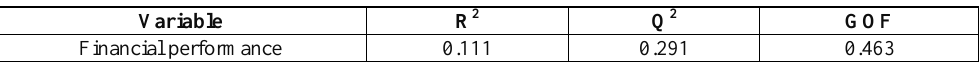
Table 5. R2, Q2 and GOF